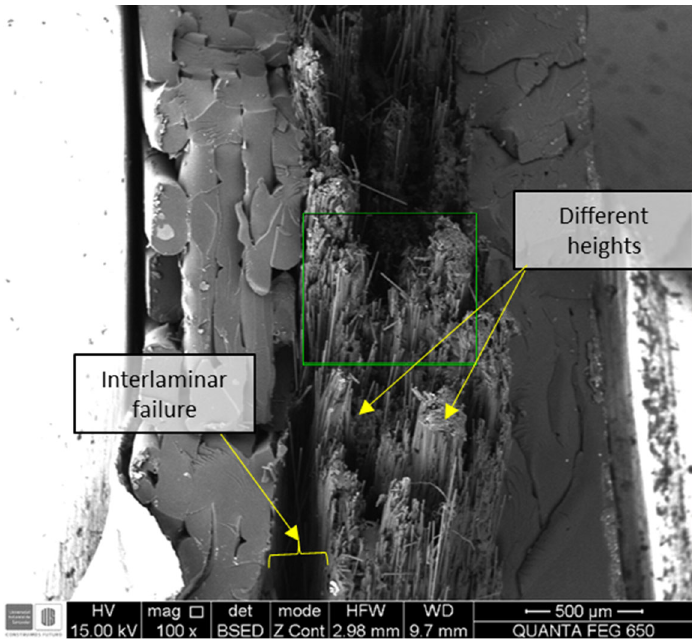
Figure 18. Fractography of a 0° 6/16 fiber ‐ reinforced tensile test.